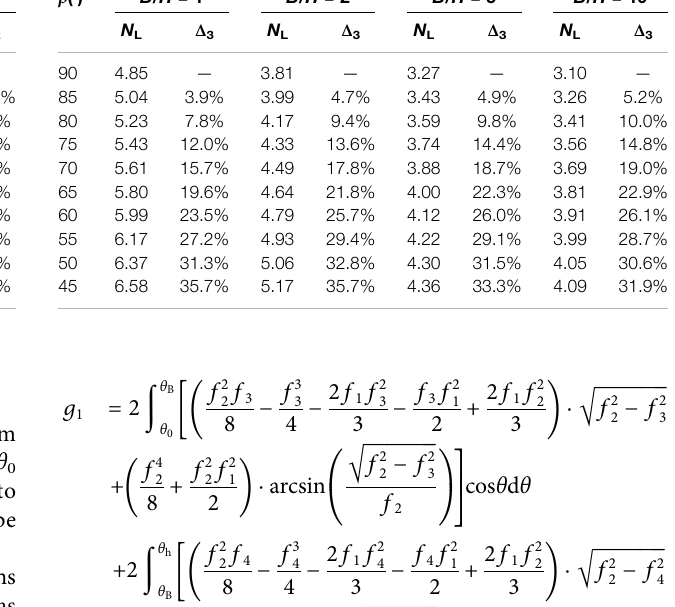
TABLE 2 | Effects of the ratio B/H on stability factor N L ( k h (cid:1) 0.2, ζ (cid:1) 0.5). B/H